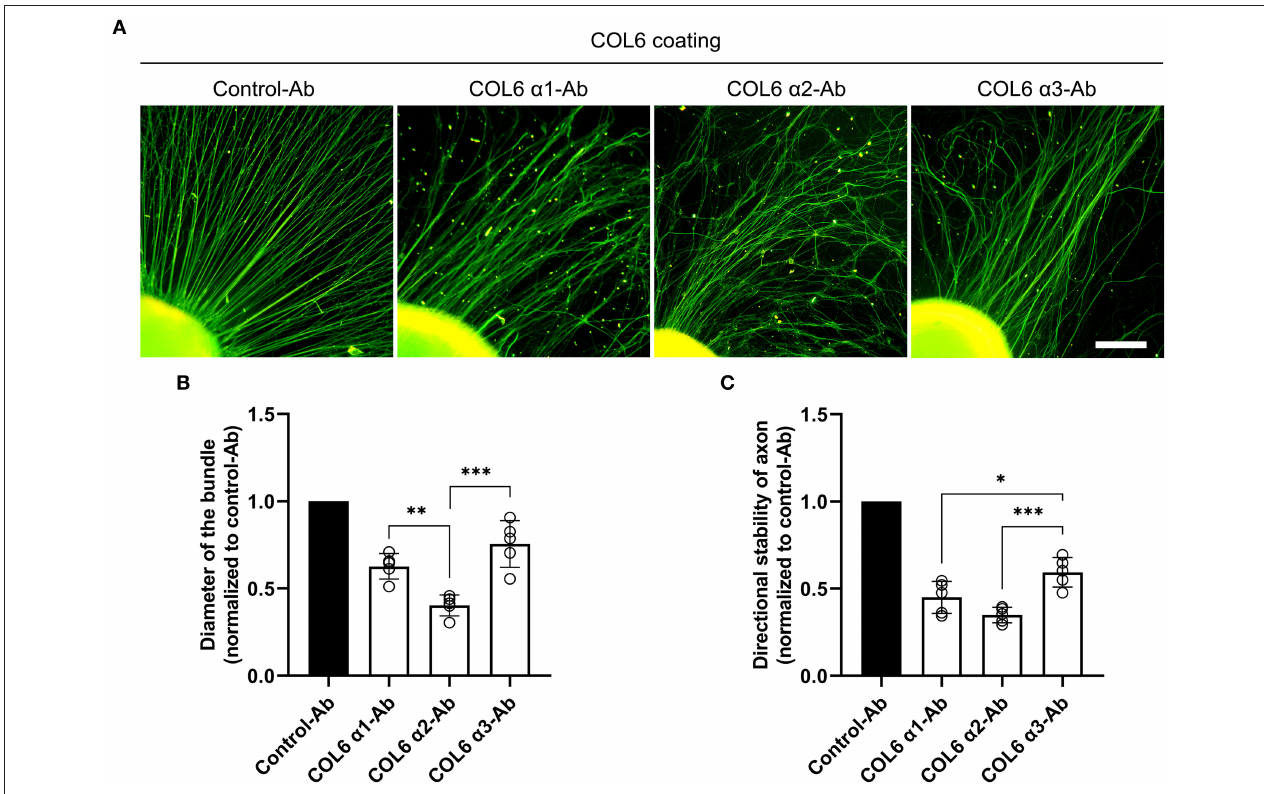
FIGURE 1 | Function-blocking of different COL6 α chains hinders nerve bundle formation in various degrees. DRGs cultured on the COL6-coated surface were subjected to an antibody-blocking assay. (A) DRGs treated with control-antibody (an antibody against GAPHD) exhibited radially aligned axon bundles. The antibodies to different COL6 α chains gave rise to disorganized axons in varying degrees. (B) The relative values of axon bundle diameters are compared among different experimental groups ( n = 5 independent biological experiments, ** p = 0.0074, *** p = 0.0002, one-way ANOVA followed by Tukey’s multiple comparison tests). (C) Histogram showing the relative values of directional stability of axons in different groups ( n = 5 independent biological experiments, * p = 0.0287, *** p = 0.0008, one-way ANOVA followed by Tukey’s multiple comparisons tests). Scale bar = 200 µ m.